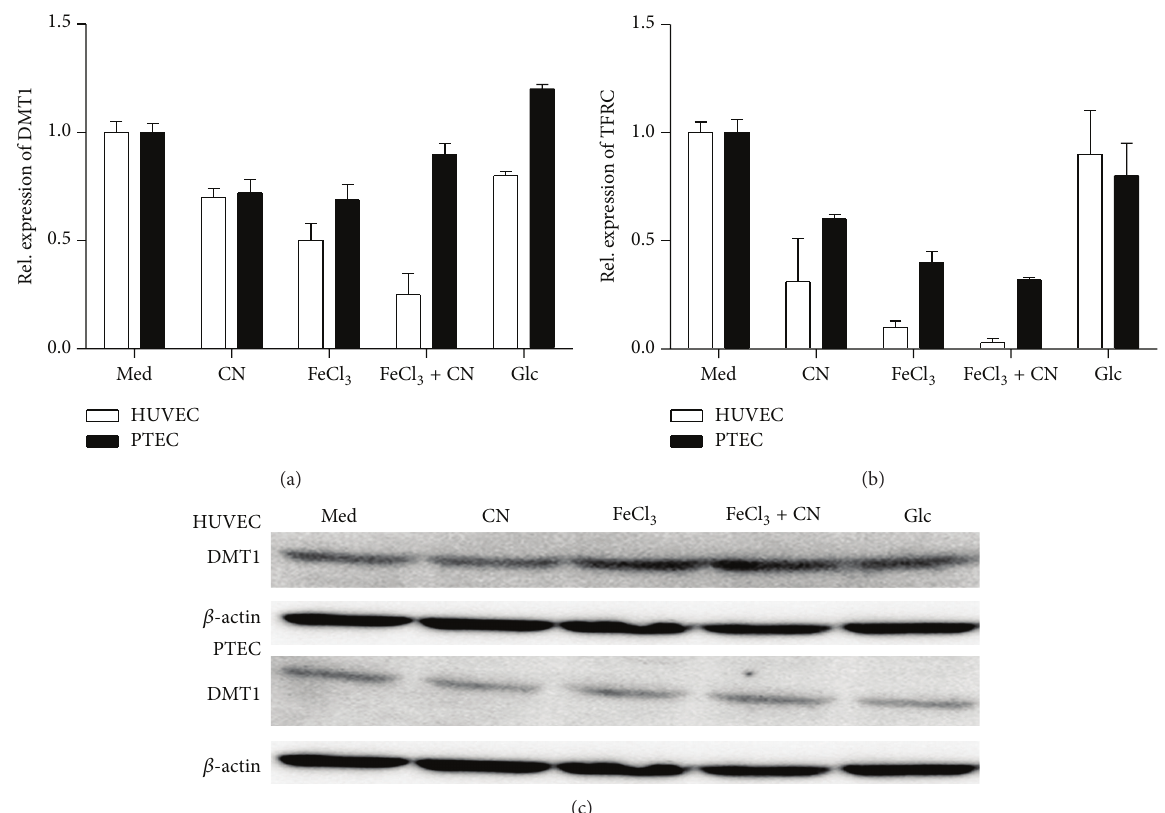
Figure 4: Influence of glucose and L-carnosine on DMT1 (a) and TFRC (b) mRNA expression. HUVECs (open bars) and PTECs (filled bars) were cultured for 24 h in the presence of 20 mM L-carnosine (CN), 60 𝜇 M of FeCl 3 , or both combinations. In addition cells were cultured for 3 days in HG medium (Glc). Total RNA was isolated and DMT1 (a) and TFRC (b) mRNA expression were assessed by qPCR. In (c) protein expression of DMT1 in HUVECs and PTECs is